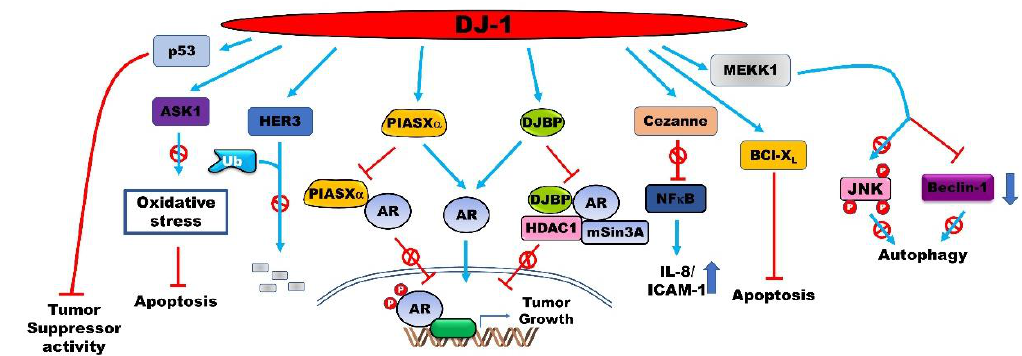
Figure 2. PARK7 enhances the proliferation and aggressiveness of cancer cells by regulating the activity of several proteins via direct interactions. PARK7 binds to oncoproteins and tumor suppressors to regulate their activation, stabilization, and cellular localization. This subsequently enhances the metastatic potential of cancer cells and protects them from apoptosis and autophagy.